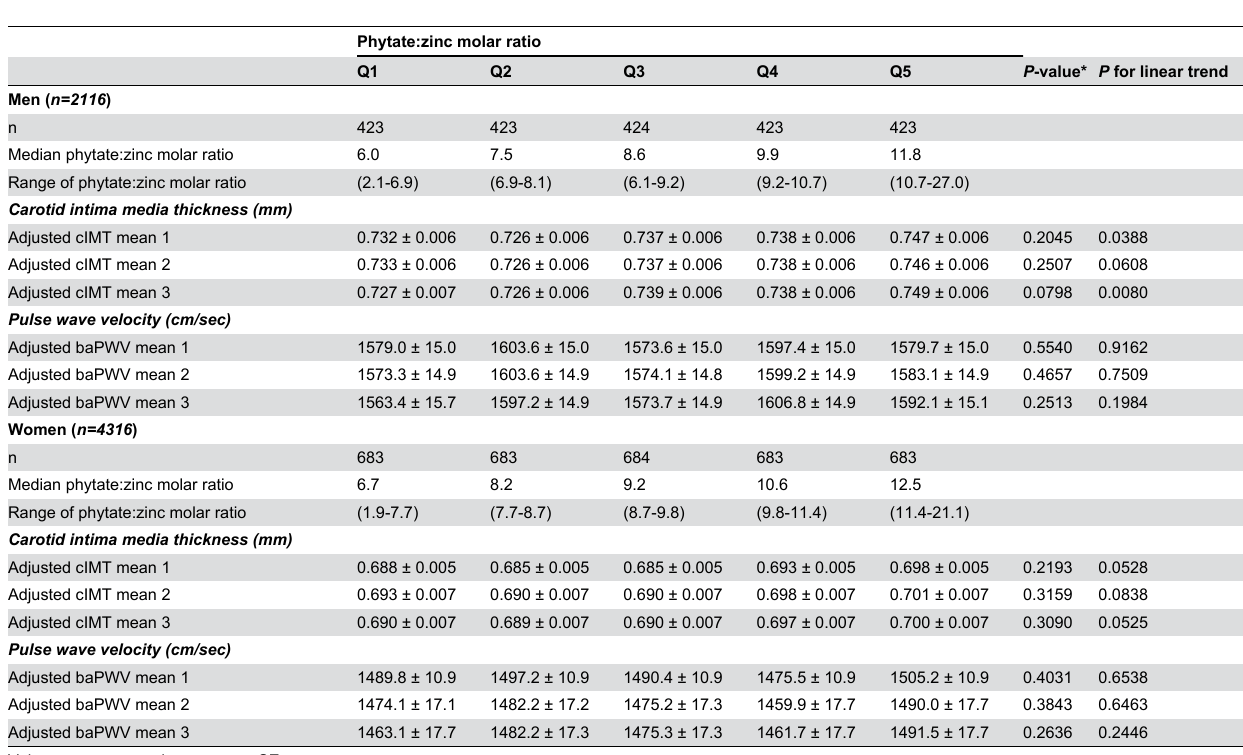
Table 3. Subclinical atherosclerosis index in the study subjects according to daily phytate:zinc molar ratio group.